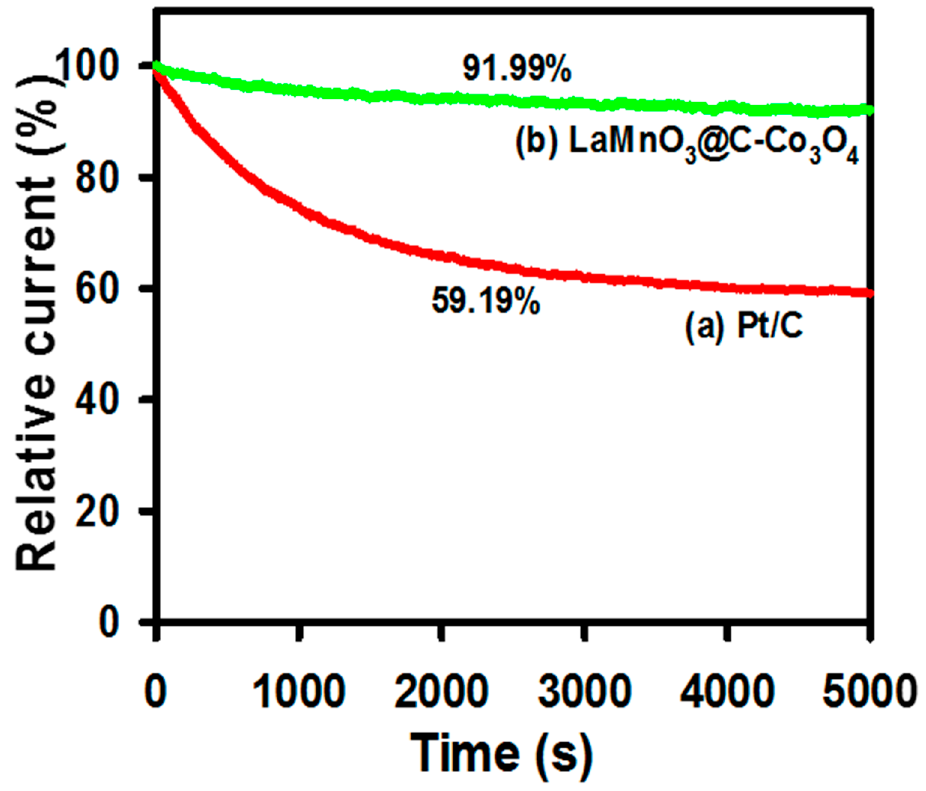
Figure 6. Chronoamperometry curves for stability of Pt/C ( a ) and LaMnO 3 @C-Co 3 O 4 composite electrode, ( b ) in O 2 -saturated 0.1 M KOH electrolyte at a fixed peak potential with rotation speed of 1600 rpm.